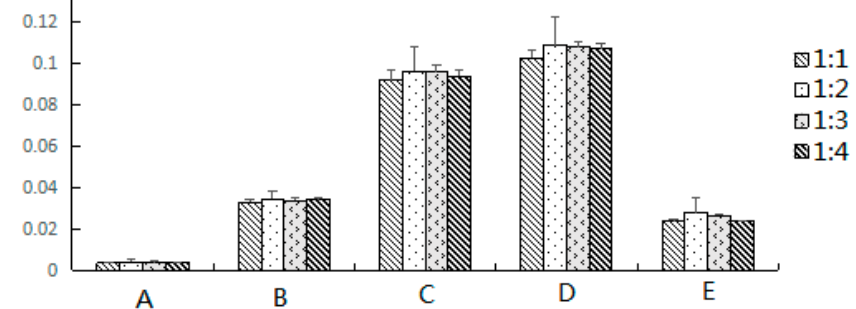
Figure 2. The effect of the ratio of sample to adsorbent on extraction yields (%) of: Scopoletin (A); 2,4-Dihydroxy-6-methoxy-3-methylacetophenone (B); 17-Hydroxyjolkinolide B (C); Jolkinolide B (D); and Jolkinolide A (E), from E. fischeriana .